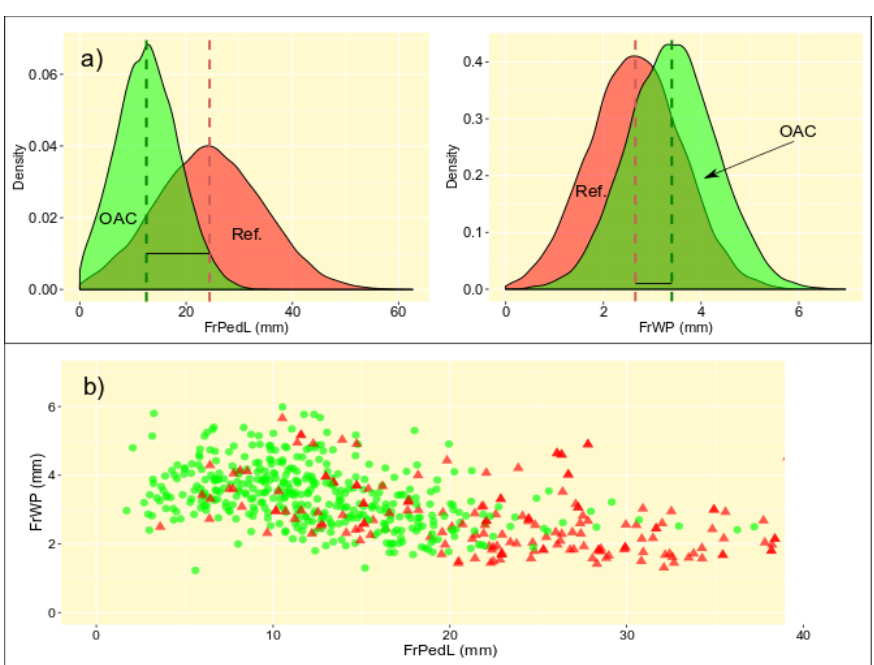
Figure 2. Diversity in the morphological descriptors of fruit peduncle length (FrPedL) and peduncle width (FrWP): a) density model of fruit peduncle length (FrPedL; left) and peduncle width (FrWP; right) from each mean and variance. Curves were computed with the rnorm(20000, − x , s 2 ) code from R. Red, reference cultivars (Ref.); Green, old apple cultivars (OAC); b) significant negative correlation between both continuous descriptors. Red triangles, reference cultivars; green circles, old apple cultivars.